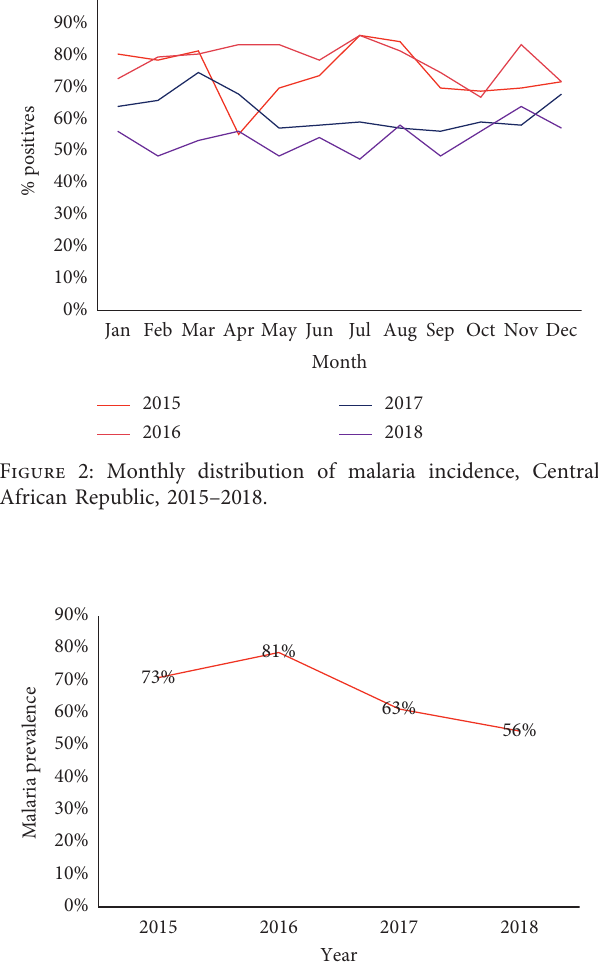
Figure 3: Yearly distribution of malaria, Central African Republic,